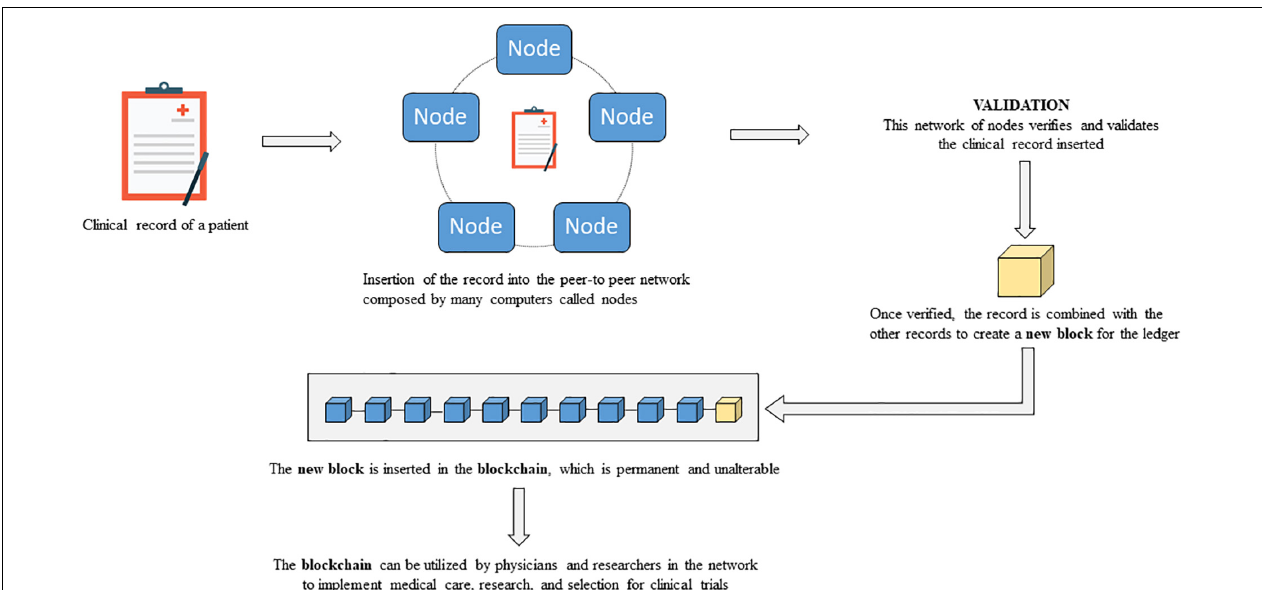
FIGURE 2 | Representative scheme of the use of blockchain technology in Medicine. When a clinical record of a patient is inserted into the peer-to-peer network, it undergoes a process of verification and validation. After that, the record is inserted as a new block into the existing blockchain. Once into the blockchain, the record cannot be changed without the permission of the network components. This allows a high level of security and permits the doctors of the network to use this information to implement medical care, research, and the selection for clinical